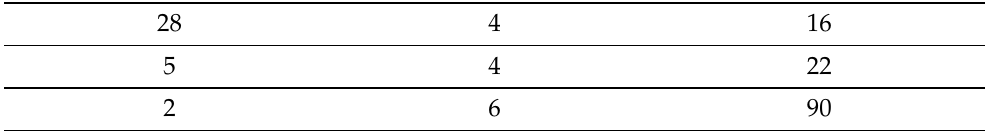
Table 10. Confusion matrix for Glove embedding with F Classifier feature selection method and 100